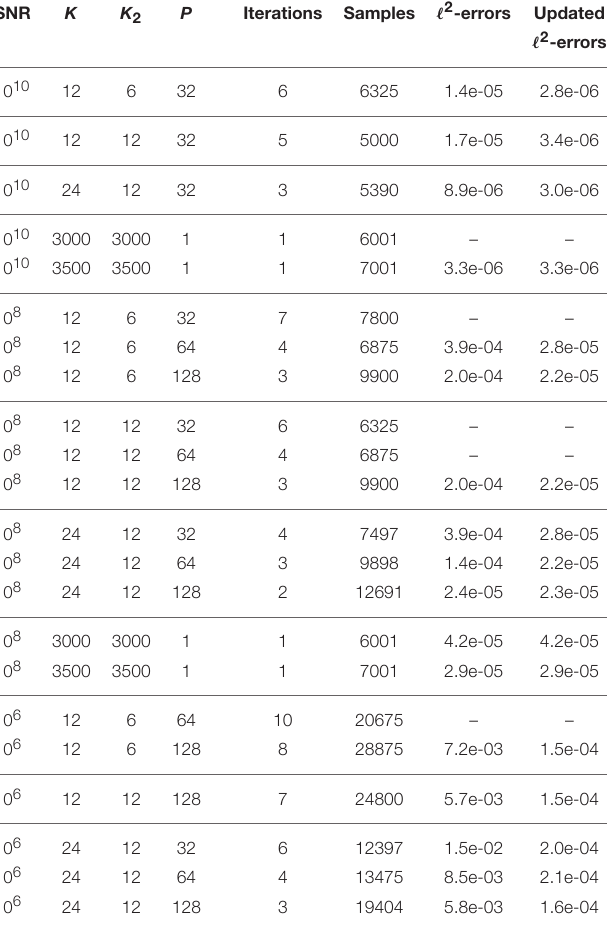
TABLE 7 | Results for Algorithm 3.2 via ESPRIT for frequency grid parameter S = 2 16 and sparsity M = 256 with noisy data.